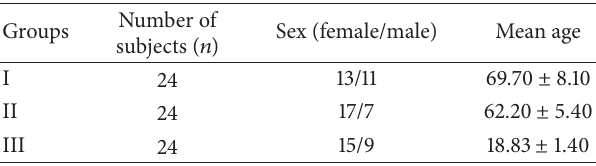
Table 1: Descriptive statistics (subject number, sex, and mean age) of study groups.